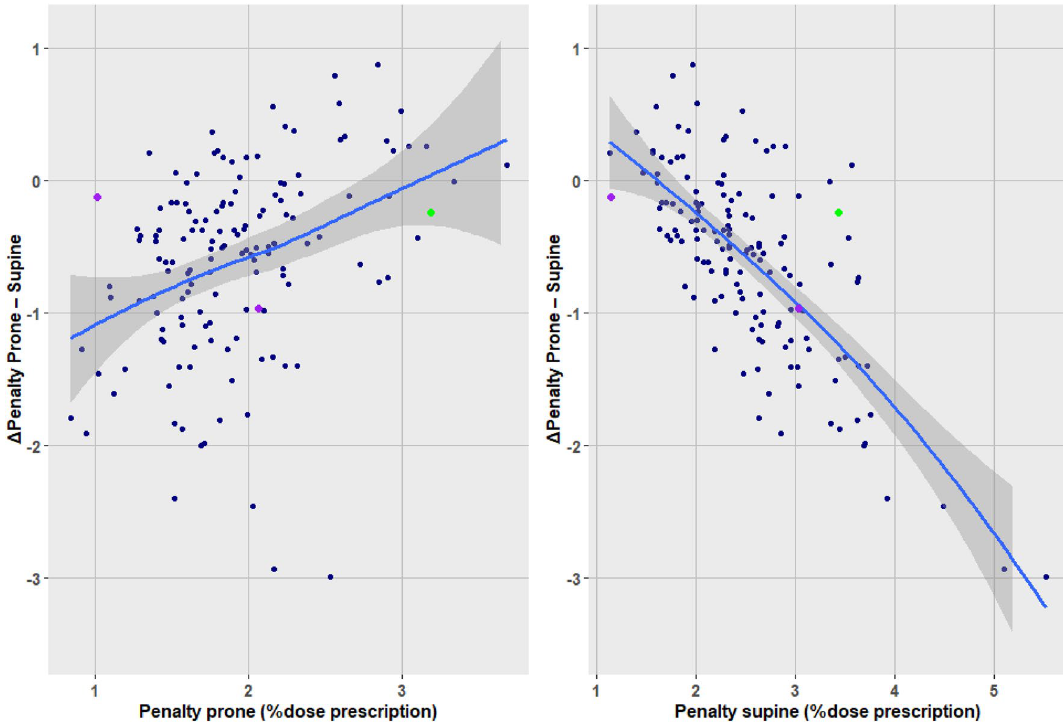
Figure 6. The ΔPenalty as a function of penalty prone or supine. Blue curve, local polynomial fit. Grey band, 95% confidence. Green, breast implant; purple, bilateral cases.